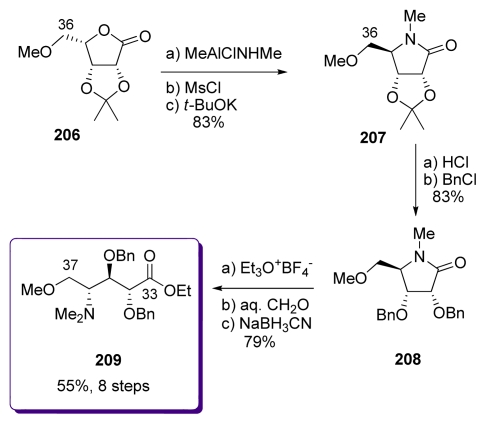
Preparation of 209.